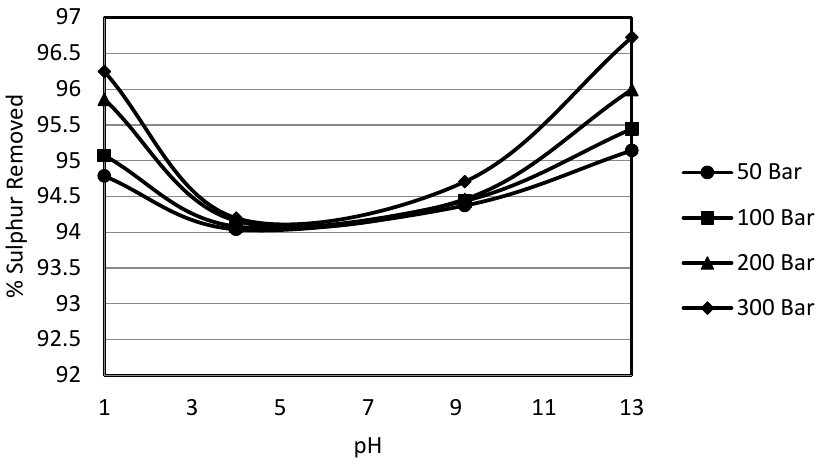
Figure 10. Effect of pressure on organic sulphur removal.